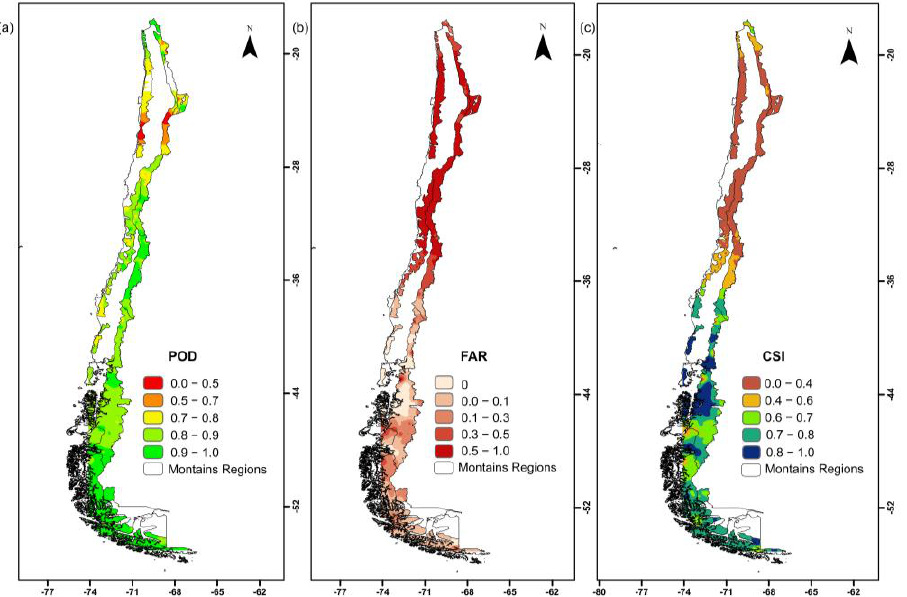
Figure 5. Satellite detection accuracy using ( a ) POD, ( b ) FAR, and ( c ) CSI over mountainous regions.